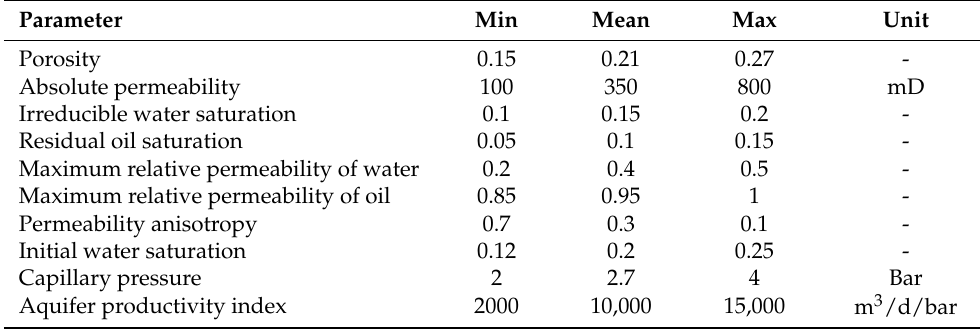
Table 1. The reservoir characteristics with their uncertainty range.